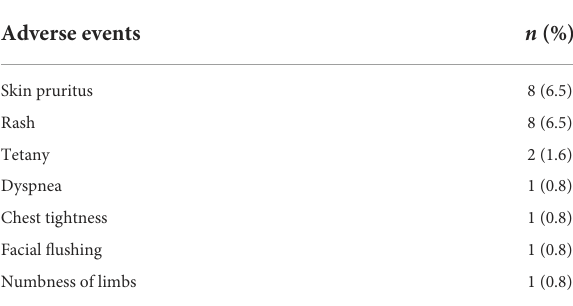
TABLE 3 Adverse reactions associated with